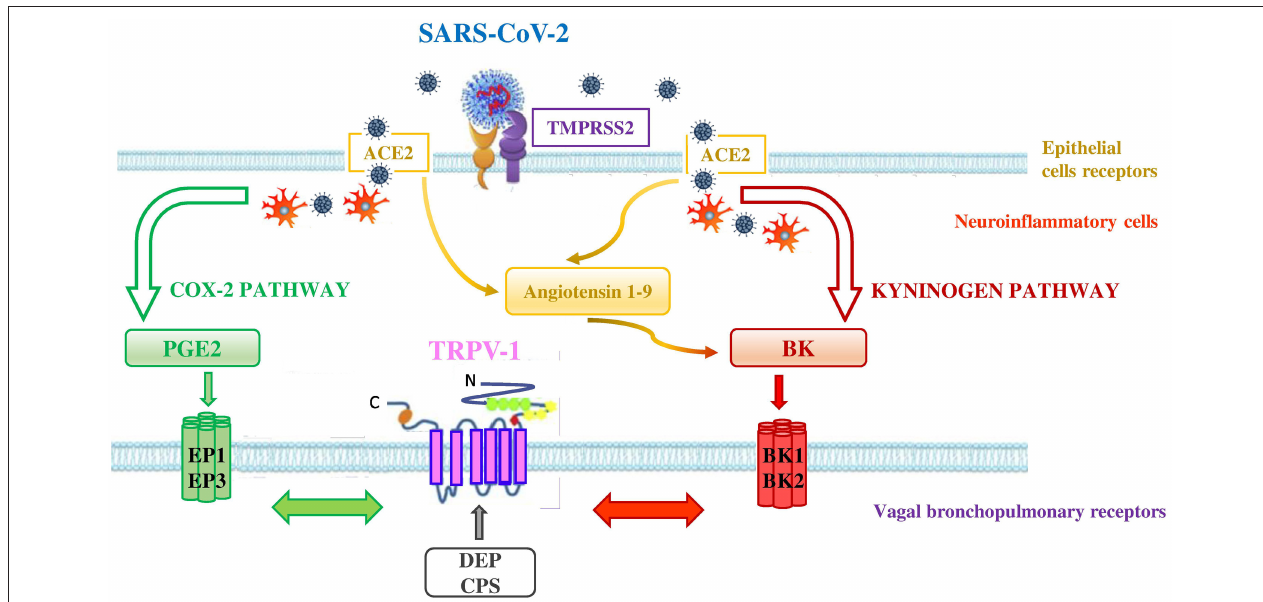
FIGURE 3 | Interconnection between ACE2, TMPRSS2, and TRPV-1 in SARS-CoV-2 infection. SARS-CoV-2 uses the ACE2 receptor for entry into lung epithelial cells and the host cell serine protease TMPRSS2 for priming the S protein. ACE2 and TMPRSS2 may interact with TRPV-1 through the activation of COX-2 and kininogen pathways. - COX-2 pathway (green pathway). TRPV-1 sensitization is due to the interaction between TRPV-1 and EP receptors (i.e., EP1 and EP3) stimulated by the increase of PGE2 levels in the lungs of affected COVID-19 patients. SARS-CoV-2 interaction with neuroinflammatory cells increases levels of PGE2a potent inflammatory mediator that is generated by COX-2 conversion of arachidonic acid.- kininogen pathway (red pathway). TRPV-1 sensitization is due to the interaction between TRPV-1 and BK receptors (i.e,. BKB1 and BKB2) stimulated by the increase of BK levels in the lungs. SARS-CoV-2 interaction with neuroinflammatory cells increases levels of BK, referred to as a “Bradykinin Storm.” BK is produced from an inactive pre-protein kininogen through activation by the serine protease kallikrein. The upregulation of ACE2 in patients with severe symptoms of COVID-19 increases Angiotensin 1–9 levels that in turn raise the levels of BK. High levels of PM in air pollution, such as DEP, directly interact with TRPV-1 (gray arrow) by modulating its activity and increasing its sensitization. This interaction could worsen the outcome of COVID-19 disease in affected patients. Adapted from (